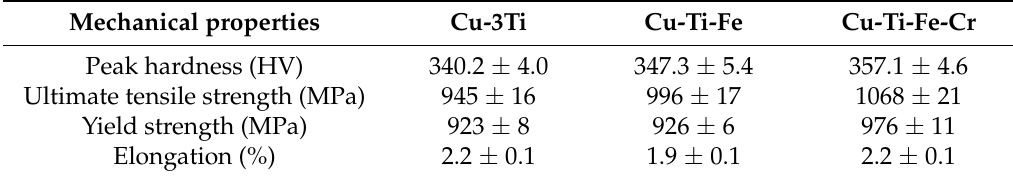
Table 1. Comparison of mechanical properties of three alloy foils in the peak-aged